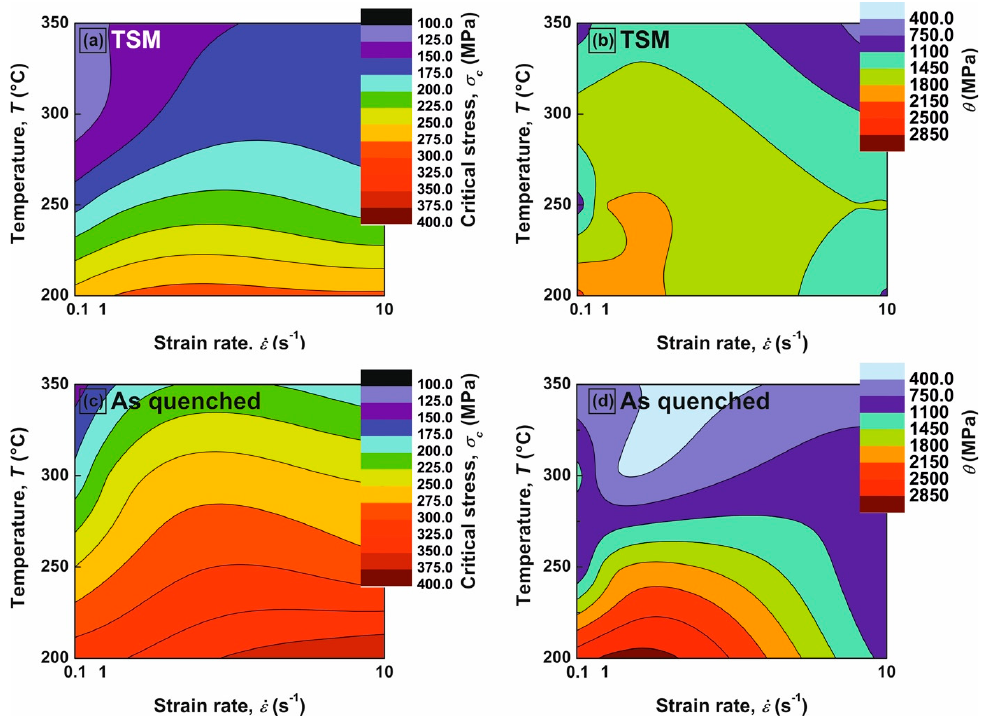
Figure 6. Strain-hardening parameter of the investigated precipitation-hardenable aluminum alloy Fig 6. AA7075 at deformation temperatures ranging from T DT = 200 ◦ C to T DT = 350 ◦ C and strain rates Metals 2022 , 12 , x FOR PEER REVIEW . . ε = 0.1 s − 1 to ε = 10 s − 1 for ( a , b ) TSM and ( c , d ) for as-quenched conditions. from